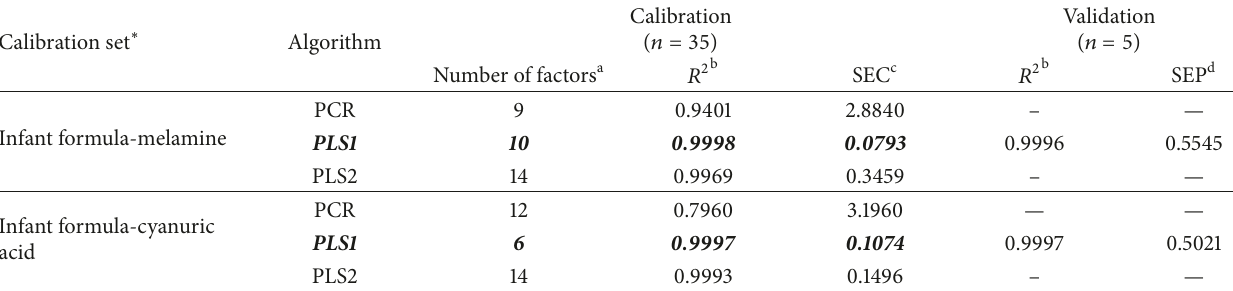
Figure 2: Mid-FTIR spectra of infant formula powder with different concentrations of (a) melamine (0.5–20 𝜇 g/L) and (b) cyanuric acid (0.5–20 𝜇 g/L). Table 1: Calibration and validation data of the models developed with PCR, PLS1, and PLS2 algorithms to predict melamine and cyanuric acid concentration in infant formula